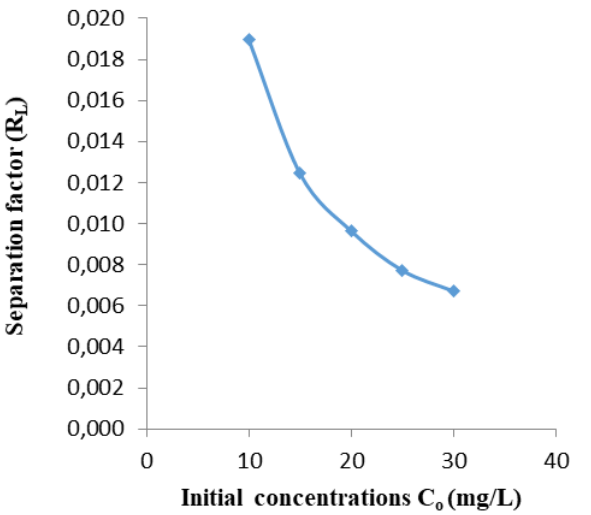
Fig. 14. Separation factor R L of Cd 2+ ions onto SEZ